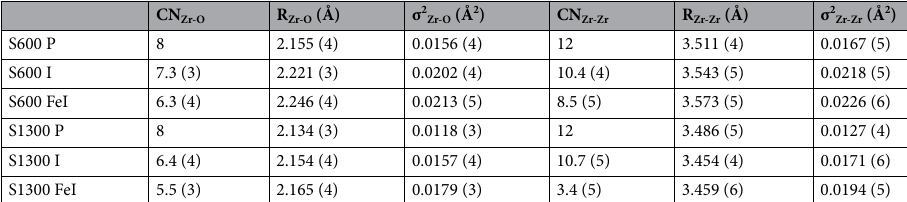
Table 2. Local structural parameters obtained from fitting of the experimental EXAFS data. The uncertainty in the last digit is indicated by the numbers in parentheses. FeI denotes the simultaneous irradiations, I denotes the single beam